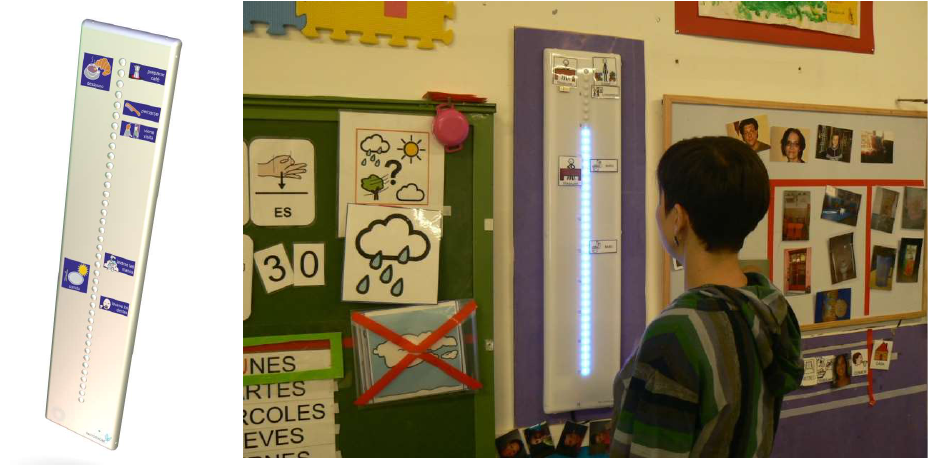
Figure 2. Second version and an example of use in the classroom.